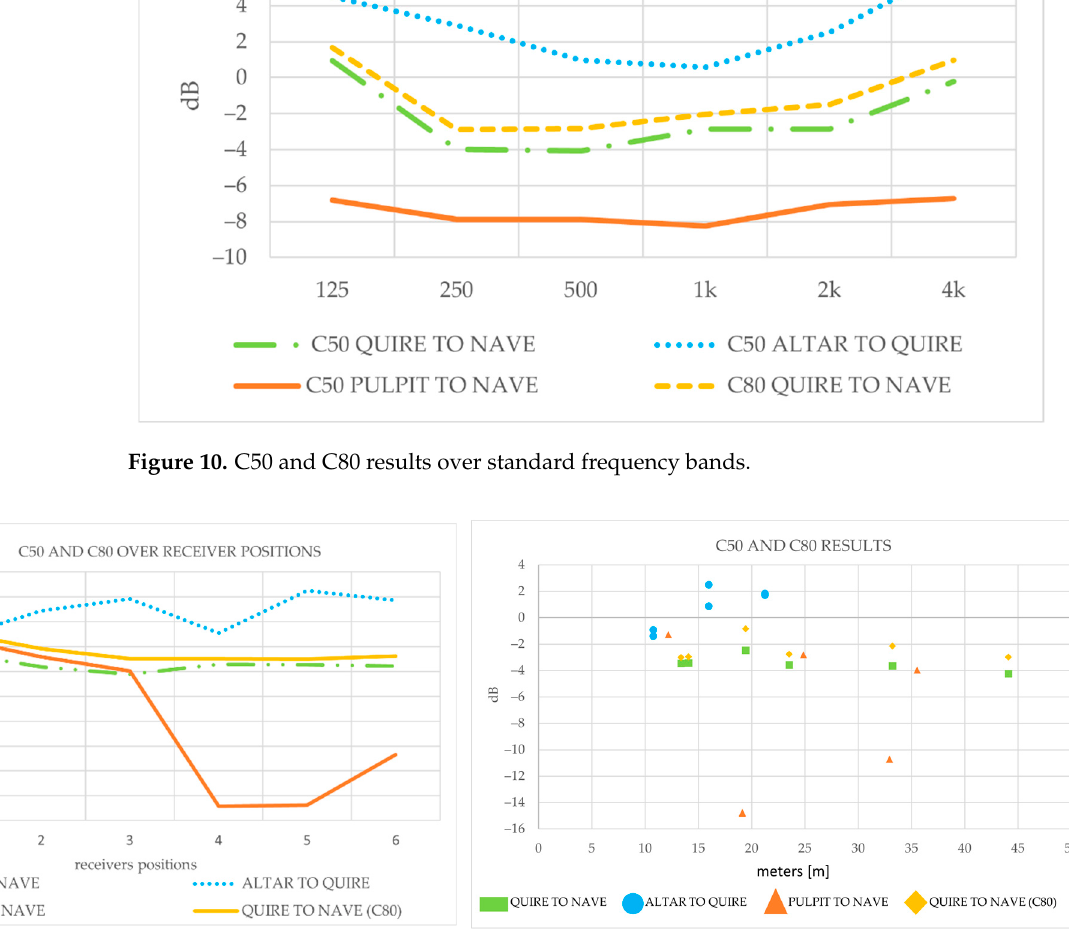
Figure 11. C50 results: ( a ) C50 results over receiver positions; ( b ) C50 results over distance.